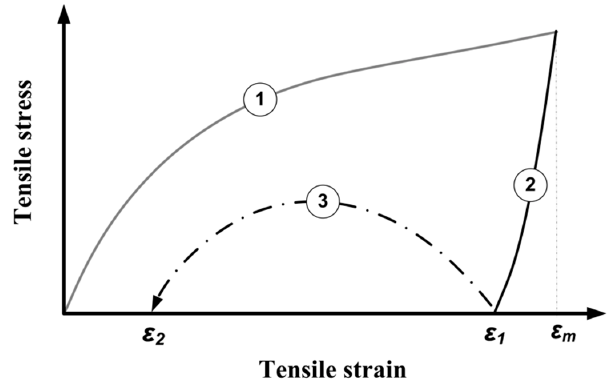
Figure 5. Illustration of stress versus strain relationship in a standard shape memory effect (SME) cycle. The numbers inside of the circles are meant for the steps.